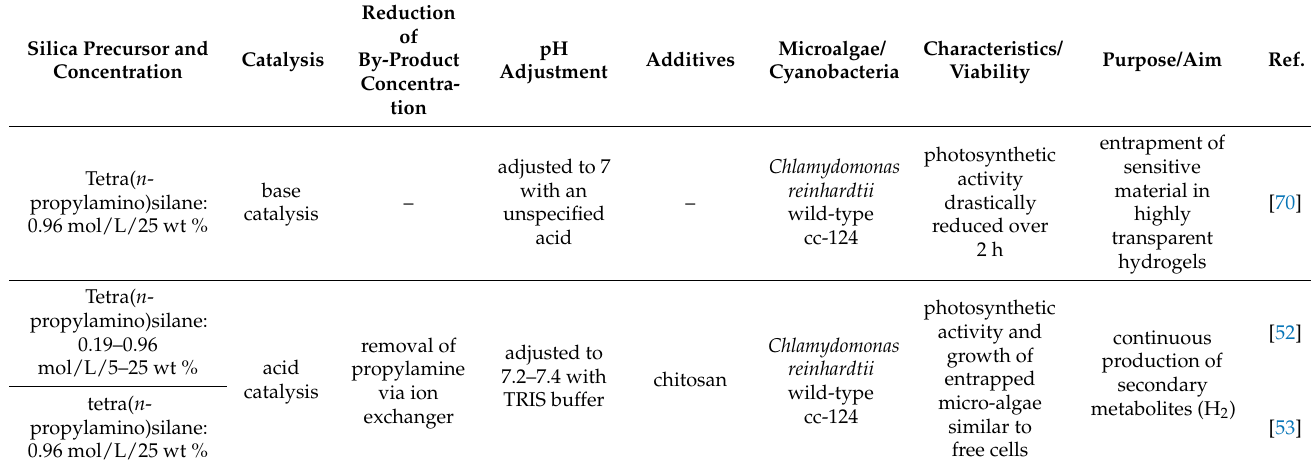
Table 4. Overview of microalgae entrapment in aminosilane-based silica